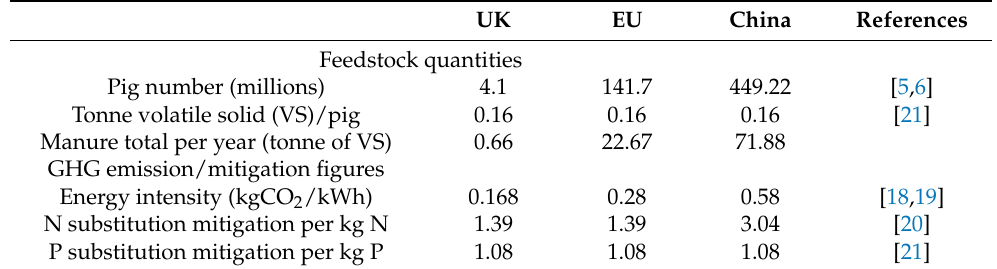
Table 1. Pig manure estimation and product emission/mitigation potential in each country. UK EU